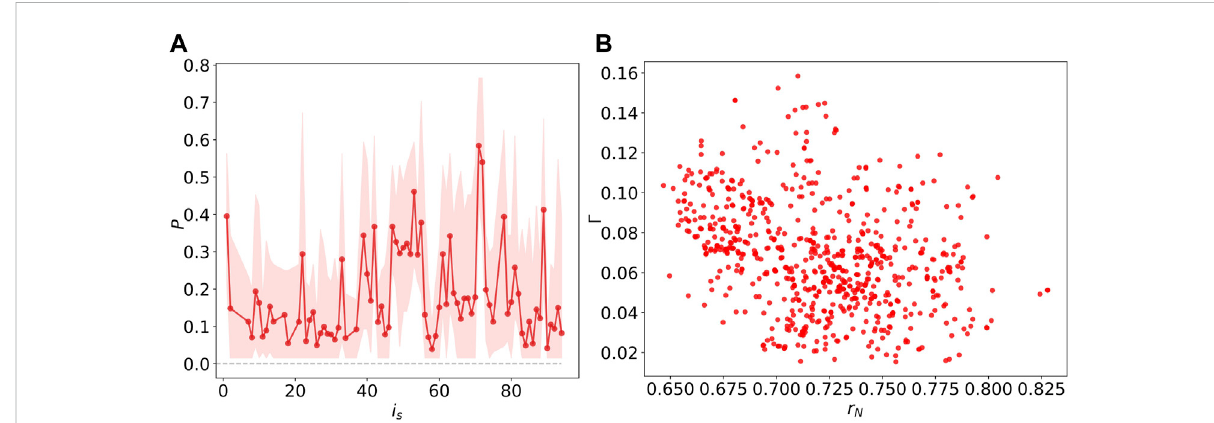
FIGURE 9 ≥ r i s . The red line represents the variations of (A) The probability P of r ξ Th in the order parameter matrix versus the stimulated node index i , ξ j averageprobabilityversusthestimulatednodeindex.Eachreddotcorrespondstoastimulatedregion.Theshadedareashowsthevariation rangeof the probability. The dashed line helps distinguish the probability P > 0 in the shaded area. (B) The chimera index Γ is weakly and negatively correlated with r N ,withthecorrelationcoef fi cient r ≈ − 0.33andthe p -value p ≈ 2.87×10 − 19 .Onereddotdescribesachimerastategenerated via thesingle regional stimulation. For each single regional stimulation, simulating Eq. 2 ten times, using 0 < P < 1 identi fi es the generated chimera states, and P i = 1.15. The time interval of simulating Eq. 2 is [0, 150 s], with step size = 0.001 s. The initial conditions are E i (0) = 0.1, I i (0) = 0.1 with i = 1, ... , N .